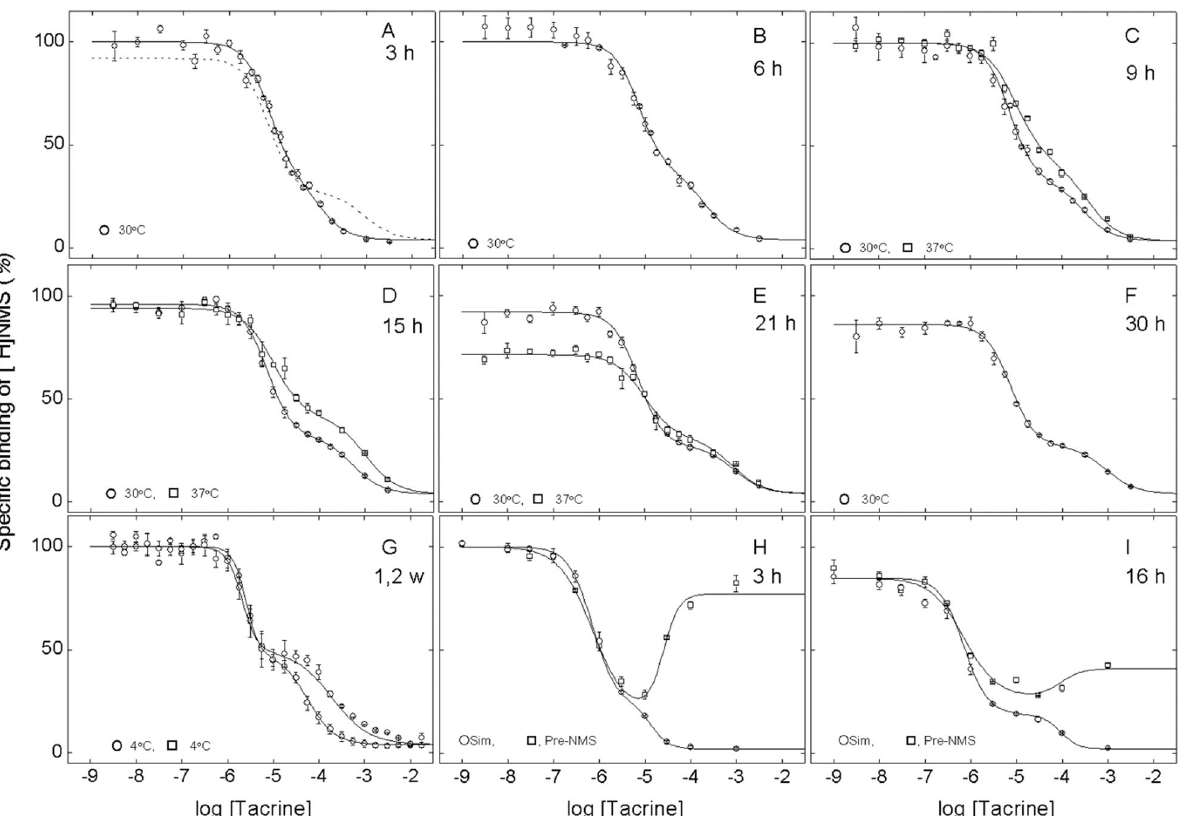
Figure 2. Equilibration of [ 3 H]NMS and tacrine with solubilized M 2 receptor from porcine atria. ( A – G ) Simultaneous addition of the two ligands. Aliquots of extract were incubated at 4 °C (open circle, open rhombus, G ), 30 °C (open circle, A – F ), or 37 °C (open square, C–E ) with [ 3 H]NMS (10 nM) plus tacrine at the concentrations shown on the abscissa. Binding was measured after incubation of the reaction mixture for different times as follows: 3 h ( A ), 6 h ( B ), 9 h ( C ), 15 h ( D ), 21 h ( E ), 30 h ( F ), 1 week (open circle, G ), and 2 weeks (open rhombus, G ). The solid lines depict the best fits of Eq. (3) ( n = 2) to all of the data acquired at the same temperature taken together, and the fitted parametric values are listed in Table S7. The fitted curve in F is reproduced as the broken line in A . ( H , I ) Sequential addition of [ 3 H]NMS and tacrine to receptor in membranes from Sf 9 cells (open square). Receptor-containing membranes were incubated with [ 3 H]NMS (0.3 nM) for 30 min at 24 ºC; tacrine then was added at the concentrations shown on the abscissa, and binding was measured after further incubation for 3 h ( H ) and 16 h ( I ) at 24 °C. As a control, membranes also were mixed simultaneously with [ 3 H]NMS and tacrine (open circle), and binding was measured after incubation for 3 h ( H ) (filled circle) and 16 h ( I ) (filled square) at 24 °C. The lines depict the best fit of Eq. (3) ( n = 2) to data obtained after sequential or simultaneous addition of the two ligands, and the parametric values are listed in Table S8. Details regarding the normalization of the data in all panels are described in